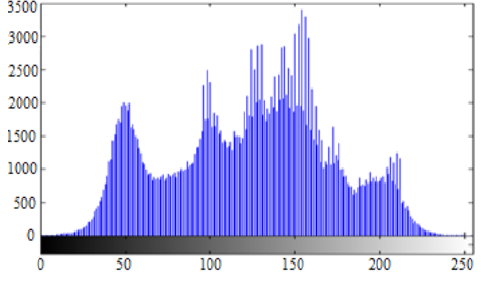
Figure 15: D k for [20] and [18]